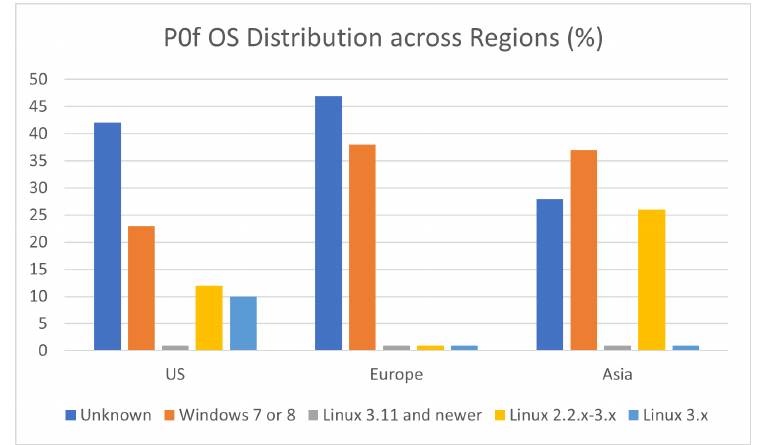
Figure 17. OS Distribution Across